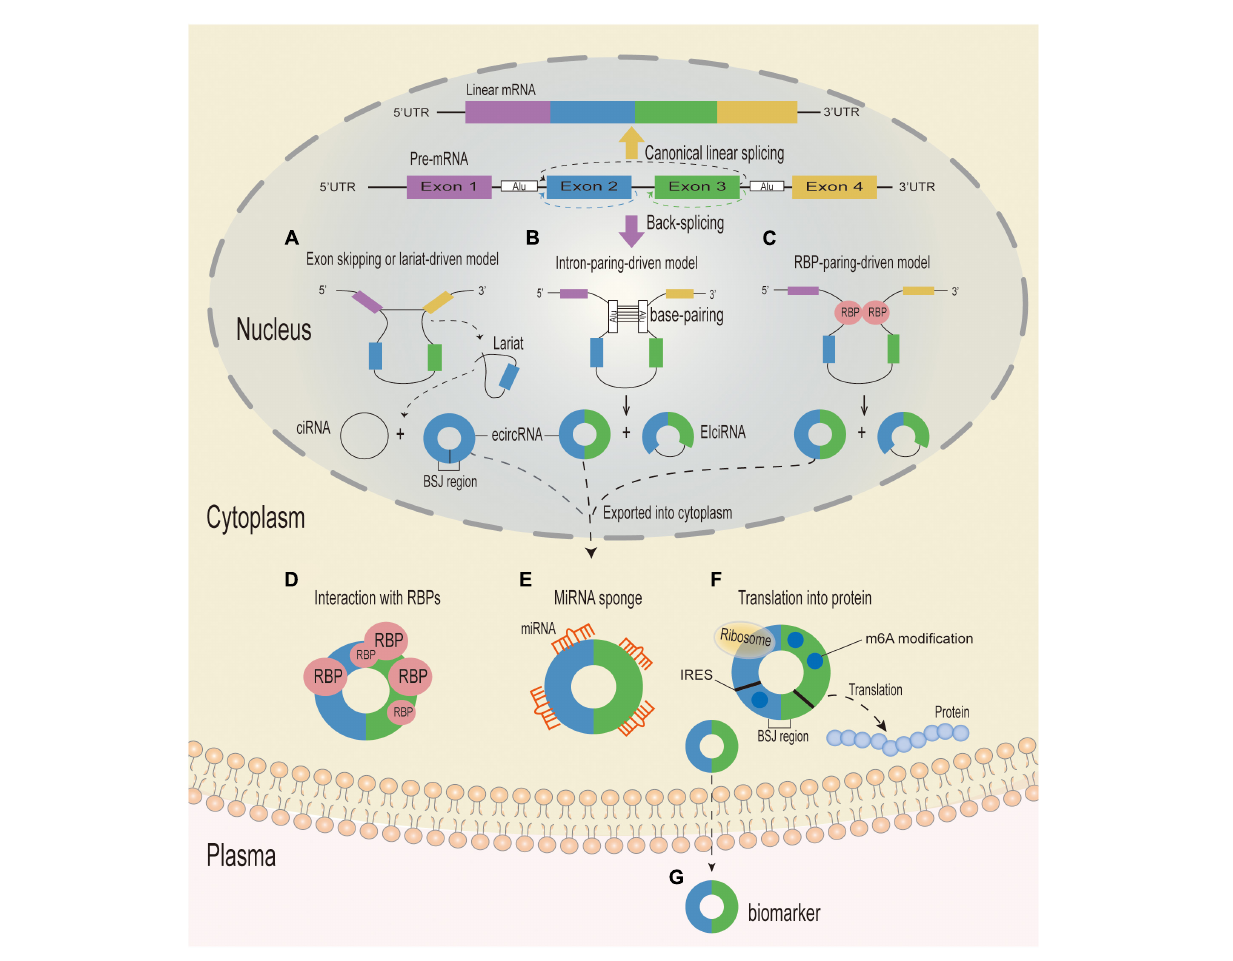
FIGURE1 Biogenesis mechanisms and putative functions of circRNA. Eukaryotic pre-mRNAs can be spliced to generate linear or circular RNA. When splice sites are joined in a linear order by the pre-mRNA splicing machinery, a canonical linear mRNA is generated (Yellow arrow). Alternatively, back-splicing can join a 5 (cid:48) splice site to an upstream 3 (cid:48) splice site, resulting in the production of a circular RNA whose ends are covalently linked by a 3 (cid:48) –5 (cid:48) phosphodiester bond (Purple arrow). (A) Exon-skipping or lariat-driven circularization. In the exon-skipping or lariat-driven model, an exon skipping event results in covalently splicing from the 3 (cid:48) splice donor site to the 5 (cid:48) splice acceptor site, which forms an RNA lariat structure containing the exon and intron and a linear product (not shown). At the same time, the introns are removed by the spliceosome to form an ecircRNA, and the intronic lariat precursors which escape from the debranching step of canonical linear splicing can form a ciRNA. (B) Direct back-splicing or intron-pairing-driven circularization. In the intron-pairing-driven model, direct base-paring of the complementary sequence motifs (such as Alu elements) forms a circulation structure and a linear product (not shown), and then the introns are removed or retained to form an ecircRNA or an EIciRNA. (C) RBP-driven circularization. In the RBP-pairing-driven model, the interaction between two RBPs can bridge two flanking introns together and form a circulation structure and a linear product (not shown), and then the introns are removed or retained to form an ecircRNA or an EIciRNA. CircRNA can be divided into three different types: ecircRNA, ciRNA and EIcRNA. CiRNAs and EIcRNAs are likely sequestered in the nucleus, while ecircRNAs are mostly exported into the cytoplasm and can play a variety of functions. (D) CircRNAs with RBP-binding motifs may function as sponges or decoys for proteins and thereby regulate their activity. (E) CircRNAs containing miRNA response elements might regulate expression of miRNA-target mRNAs through sequestering or sponging with the miRNAs. (F) CircRNAs containing IRES and/or with m6A modifications can serve as templates for translation and give rise to circRNA-specific peptides when the reading frame extends across the BSJ. (G) CircRNAs can be excreted into the extracellular space, such as plasma, and function as biomarkers. UTR, untranslated region; RBP, RNA-binding-protein; BSJ, back-splice junction; circRNA, circular RNA; ciRNA, circular intronic RNA; EIciRNAs, exon–intron circRNAs; ecircRNA, circular exonic RNA; miRNA, microRNA; IRES, Internal Ribosome Entry site; m6A,